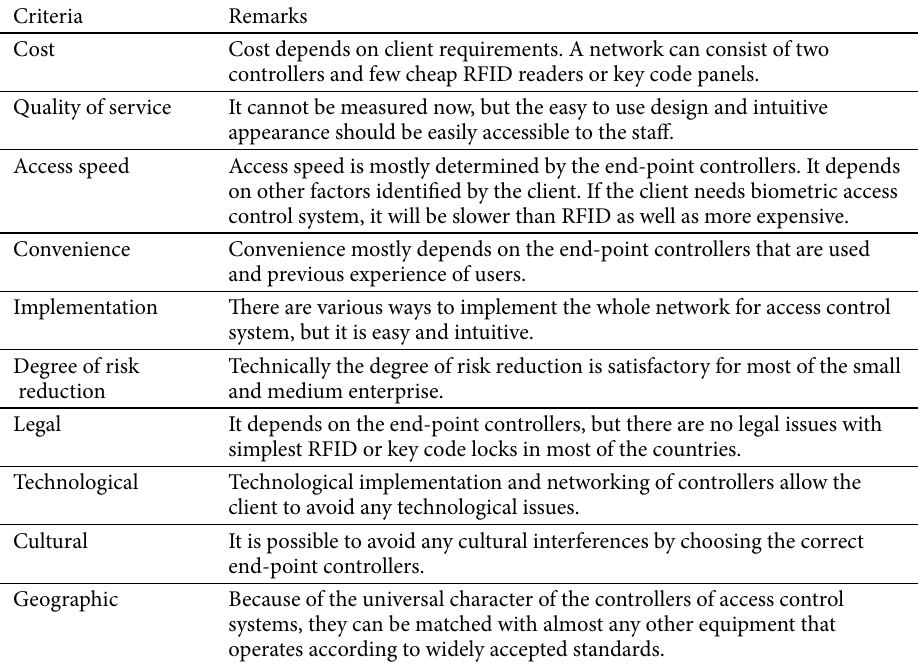
Table 1. Criteria table for manifold access control